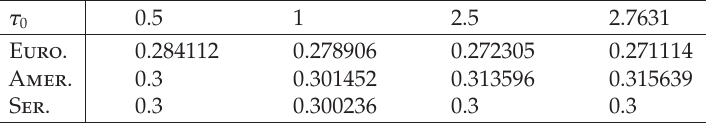
Table 2.10 . Put: Run 4; as in Table 2.7 but S = 0 . 02, and σ = 0 . D 0